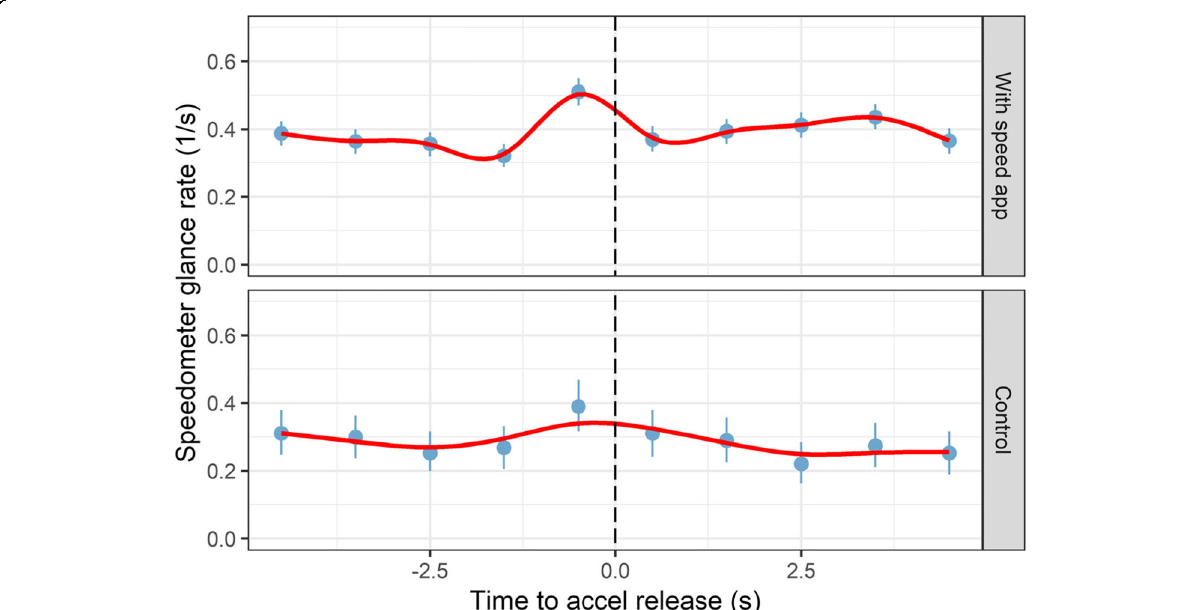
Fig. 5 The average rate of speedometer glances with 95% CI in one-second bins relative to accelerator releases by the group (rows). The two conditions with the speed app